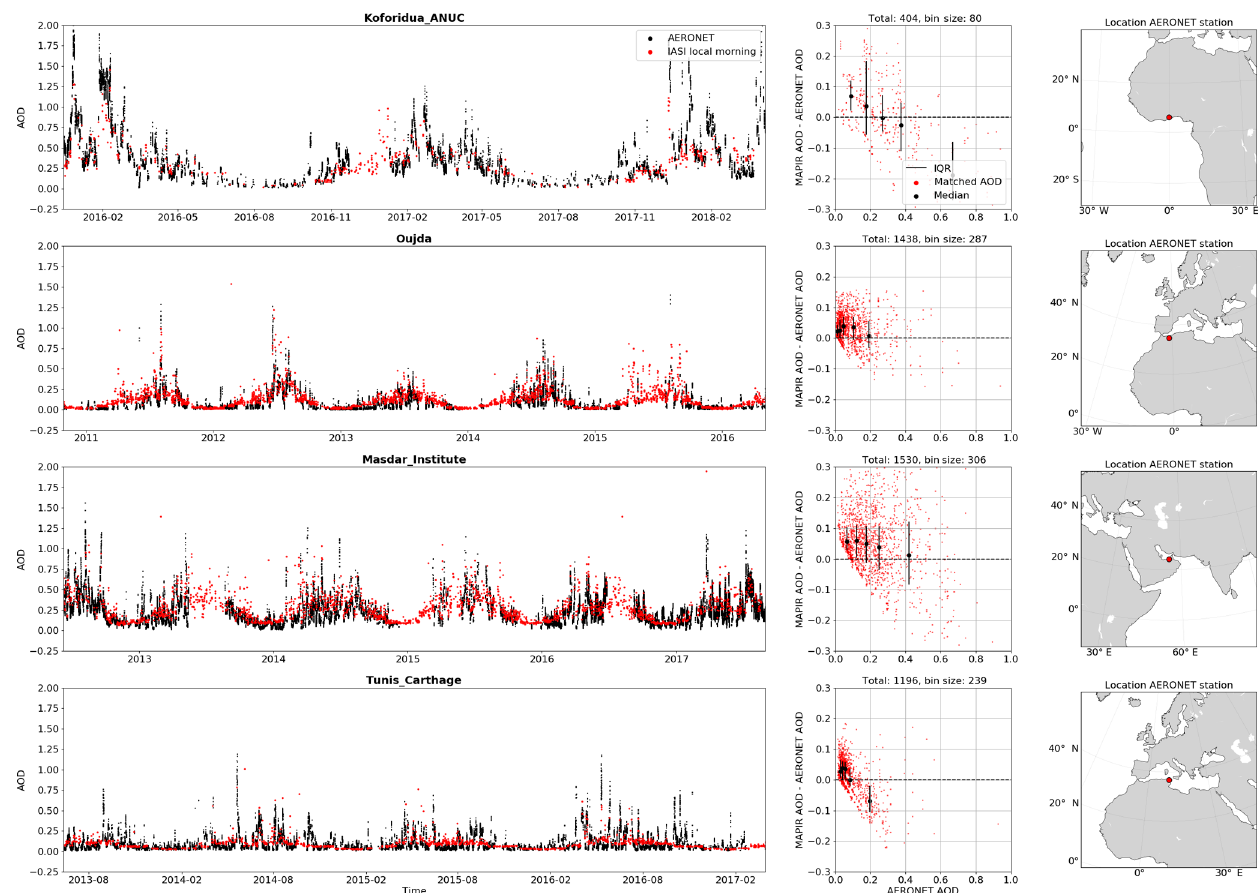
Figure 6. Time series of the available AERONET data at four stations in the first column: Koforidua ANUC, Oujda, Masdar Institute and Tunis Carthage. The black dots are the AERONET SDA coarse-mode AOD, and the red dots are the matched MAPIR AOD converted to 550nm. The second column gives the corresponding scatter plots of the difference between the matched observations, together with the median and interquartile range (IQR) of five bins of equal size. The location of each AERONET site is given in the third